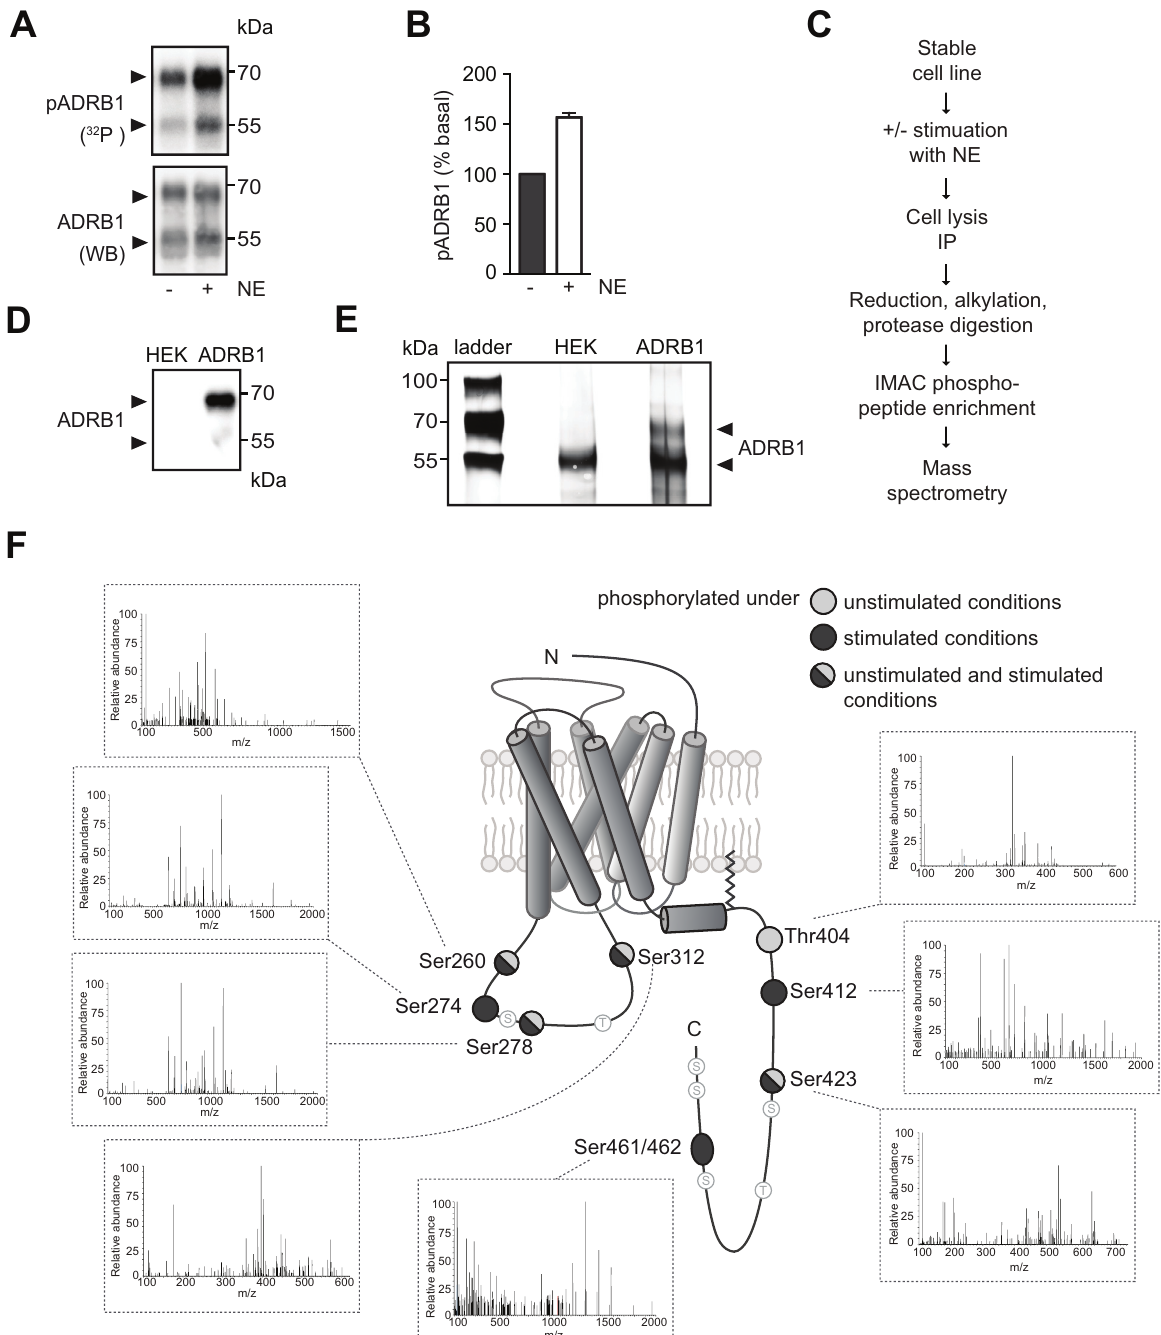
Fig 1. The β 1 -adrenoceptor is phosphorylated at multiple sites in the third intracellular loop and at the C-terminus. ( A ) Phosphorylation of the ADRB1 with and without stimulation with NE (100 μ M) for 5 min. Cells stably expressingthe humanADRB1 were cultured in medium containing1% FCS and 32 P. After cell lysis and IP of the ADRB1, the amount of phosphorylated ADRB1 (pADRB1) was quantified by phosphor imager analysis. Total ADRB1 was subsequently visualizedby western blotting. ( B ) Quantification of ADRB1 phosphorylationfrom (A), n = 3. ( C ) Preparationof samples for mass spectrometry. ( D ) Western blot after crosslink IP of the ADRB1. HEK: untransfected HEK293cells (negativecontrol); ADRB1: HEK293 cells stably expressingthe β 1 -adrenoceptor. ( E ) Silver stainingof SDS gel showingthe ADRB1 after IP. ( F ) Phosphorylationpattern of the ADRB1. Amino acids marked in light grey and black indicate phosphorylationunder basal conditionsand after stimulationwith 100 μ M NE for 5 min, respectively. Pool of five experiments. Annotated spectra of the detected phosphosites are presentedin detail in S1 Fig.